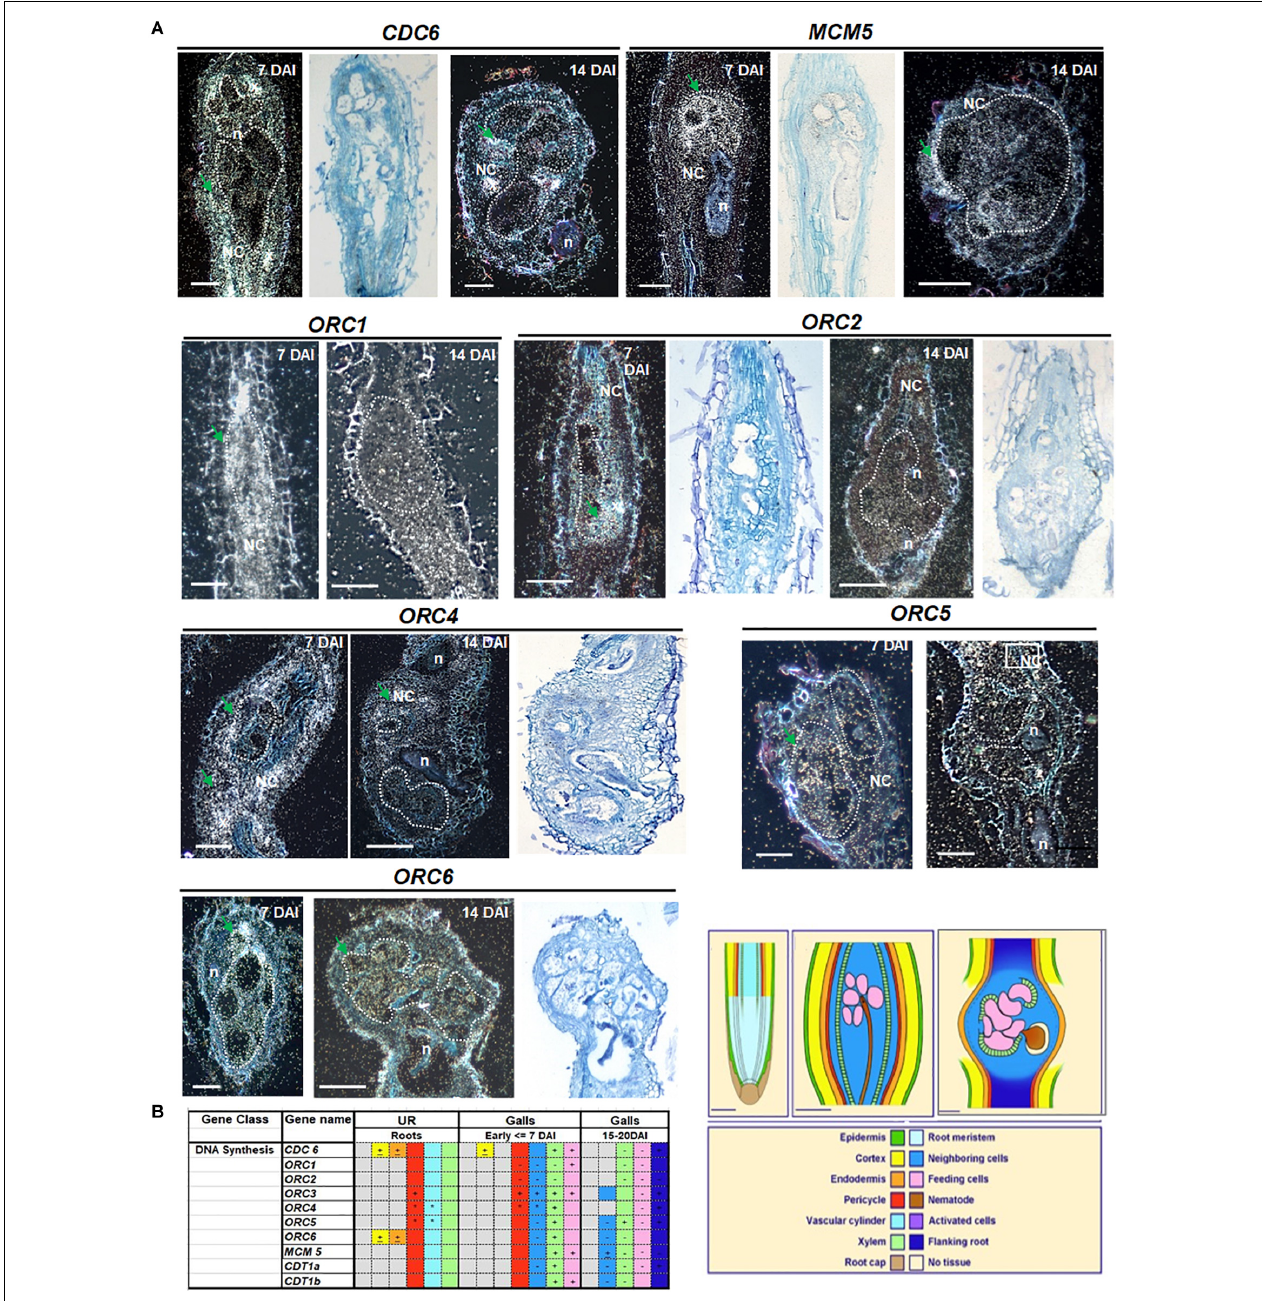
FIGURE 1 | Cell cycle pre-replication complex members: CDC6, MCM5, ORC1, ORC2, ORC3, ORC4, ORC5 , and ORC6 localization in Meloidogyne incognita- induced galls of Arabidopsis. mRNA in situ localization illustrating transcripts of CDC6, MCM5, ORC1, ORC2, ORC3, ORC4, ORC5 , and ORC6 in Meloidogyne incognita- induced galls in Arabidopsis roots and summarized data in tissue color table. (A) Dark- and bright-field images of CDC6, MCM5, ORC1, ORC2, ORC4, ORC5, and ORC6 showing mRNA in situ localization in 7 and 14 days after inoculation galls. Sections were hybridized with 35S-labeled antisense (AS) RNA probes and the hybridization signal is shown as white dots under dark-field optics and black dots under bright-field optics. Regions with high silver grain concentrations are depicted with green arrows. Feeding cells are surrounded by dotted lines. (B) Table summarizing transcript localization and hybridization intensities of genes analyzed involved in DNA synthesis. Colors in the table and drawings illustrate different tissues of an uninfected root and of young ( < 7 DAI) and mature galls (15–21 DAI). Patterns described in the table are based on at least 30 sections of each time point. Signs within colored squares represent intensity of signal: +, strong; -, weak; ± , sometimes expressed and *, patchy expression, based on visual recording of silver grain concentration. Colored squares with no sign mean intermediate levels of expression. Gray colors mean no signal, often observed for epidermis and cortical tissues. DAI, days after inoculation; n, nematode; NC, neighboring cells; UR, uninfected root. Scale bars drawings and images = 50 µ